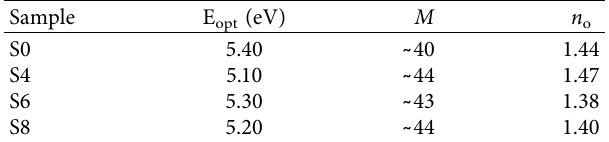
Figure 8: Variation of refractive index n with wavelength for CuONPs-doped HEC samples. Table 3: Values of optical band gap ( E opt ), number of carbon atoms ( M ) per carbonaceous cluster, and refractive index ( n o ) for CuONPs-doped HEC